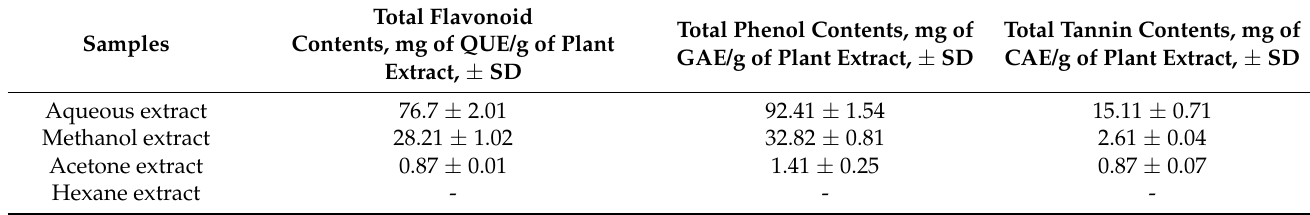
Table 2. The total phenol, flavonoid, and tannin contents of the H. lanuginosum extracts.